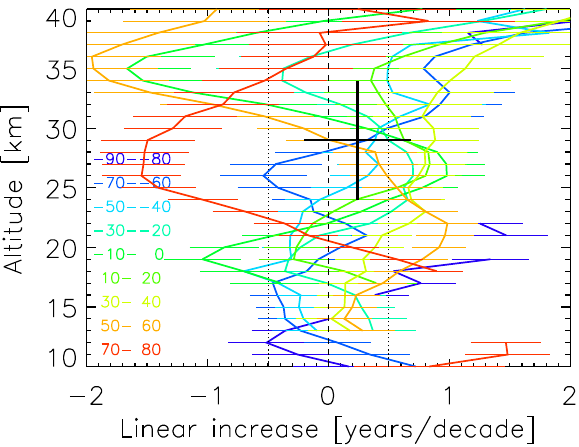
Fig. 11. Vertical profiles of the age of air linear increase/decrease over the years 2002 to 2010 for example latitudes. Horizontal bars give the 2- σ uncertainties of the linear variations. The 30-yr trend as derived by Engel et al. (2009) is also shown for comparison as a black cross indicating its valid altitude range and its 2- σ -uncertainty.